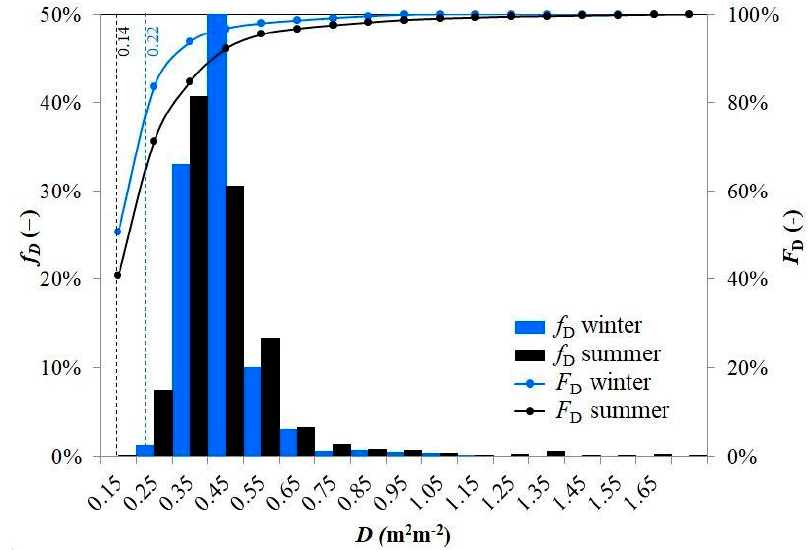
Figure 4. On the primary y-axis, the frequency of occurrence of D , f D , as the output of the segmen- tation calibration code (pilot areas representing arid and temperate periods in black and blue his- tograms, respectively). On the secondary y-axis, the cumulate of f D , F D , (dotted lines).